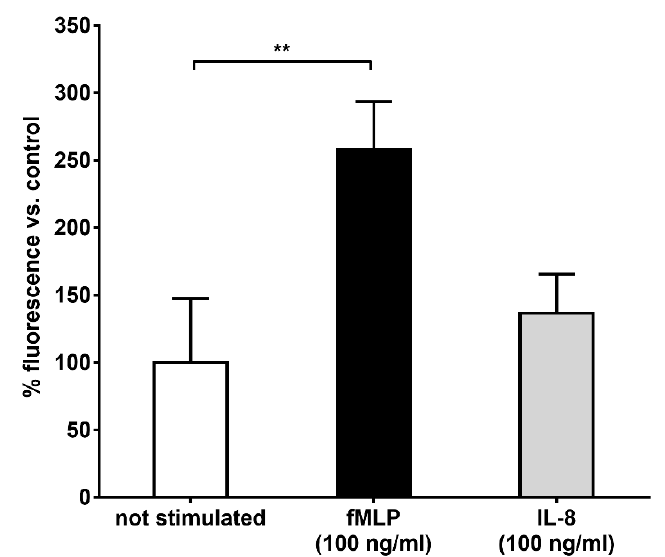
Figure 2. Increase in the binding of hydroxyethyl starch (HES) after neutrophils stimulation. Neutrophils were either activated with fMLP, IL-8 or not stimulated and then incubated with HES-FITC. After washing steps, the fluorescence was read with a microplate fluorimeter and the values were reported as percentage of binding with respect to the not stimulated condition. There was a significant increase in the binding of HES after fMLP stimulation but not after IL-8 treatment. The data represents the mean ± SD of five independent experiments. ** p < 0.01.